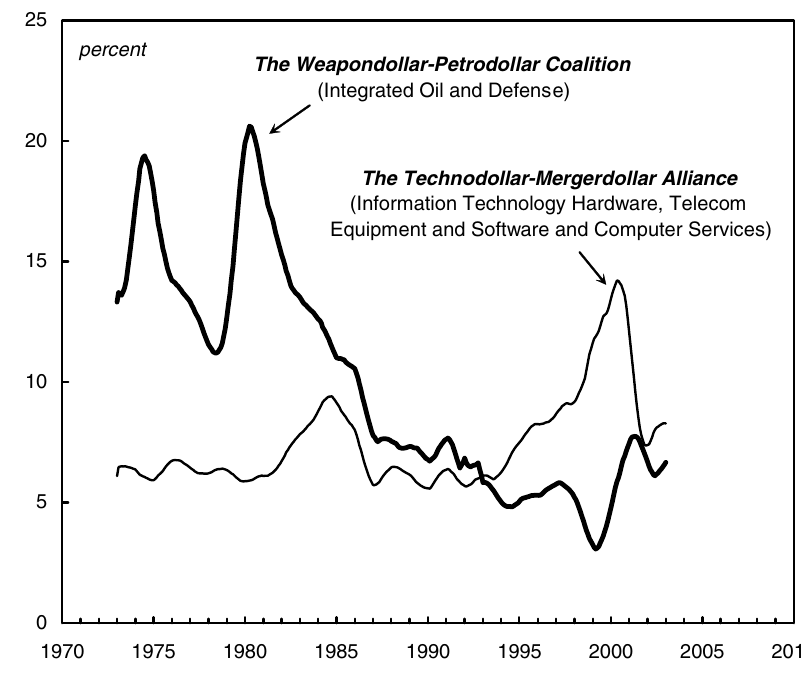
Figure 15 – Shares of Global Net Corporate